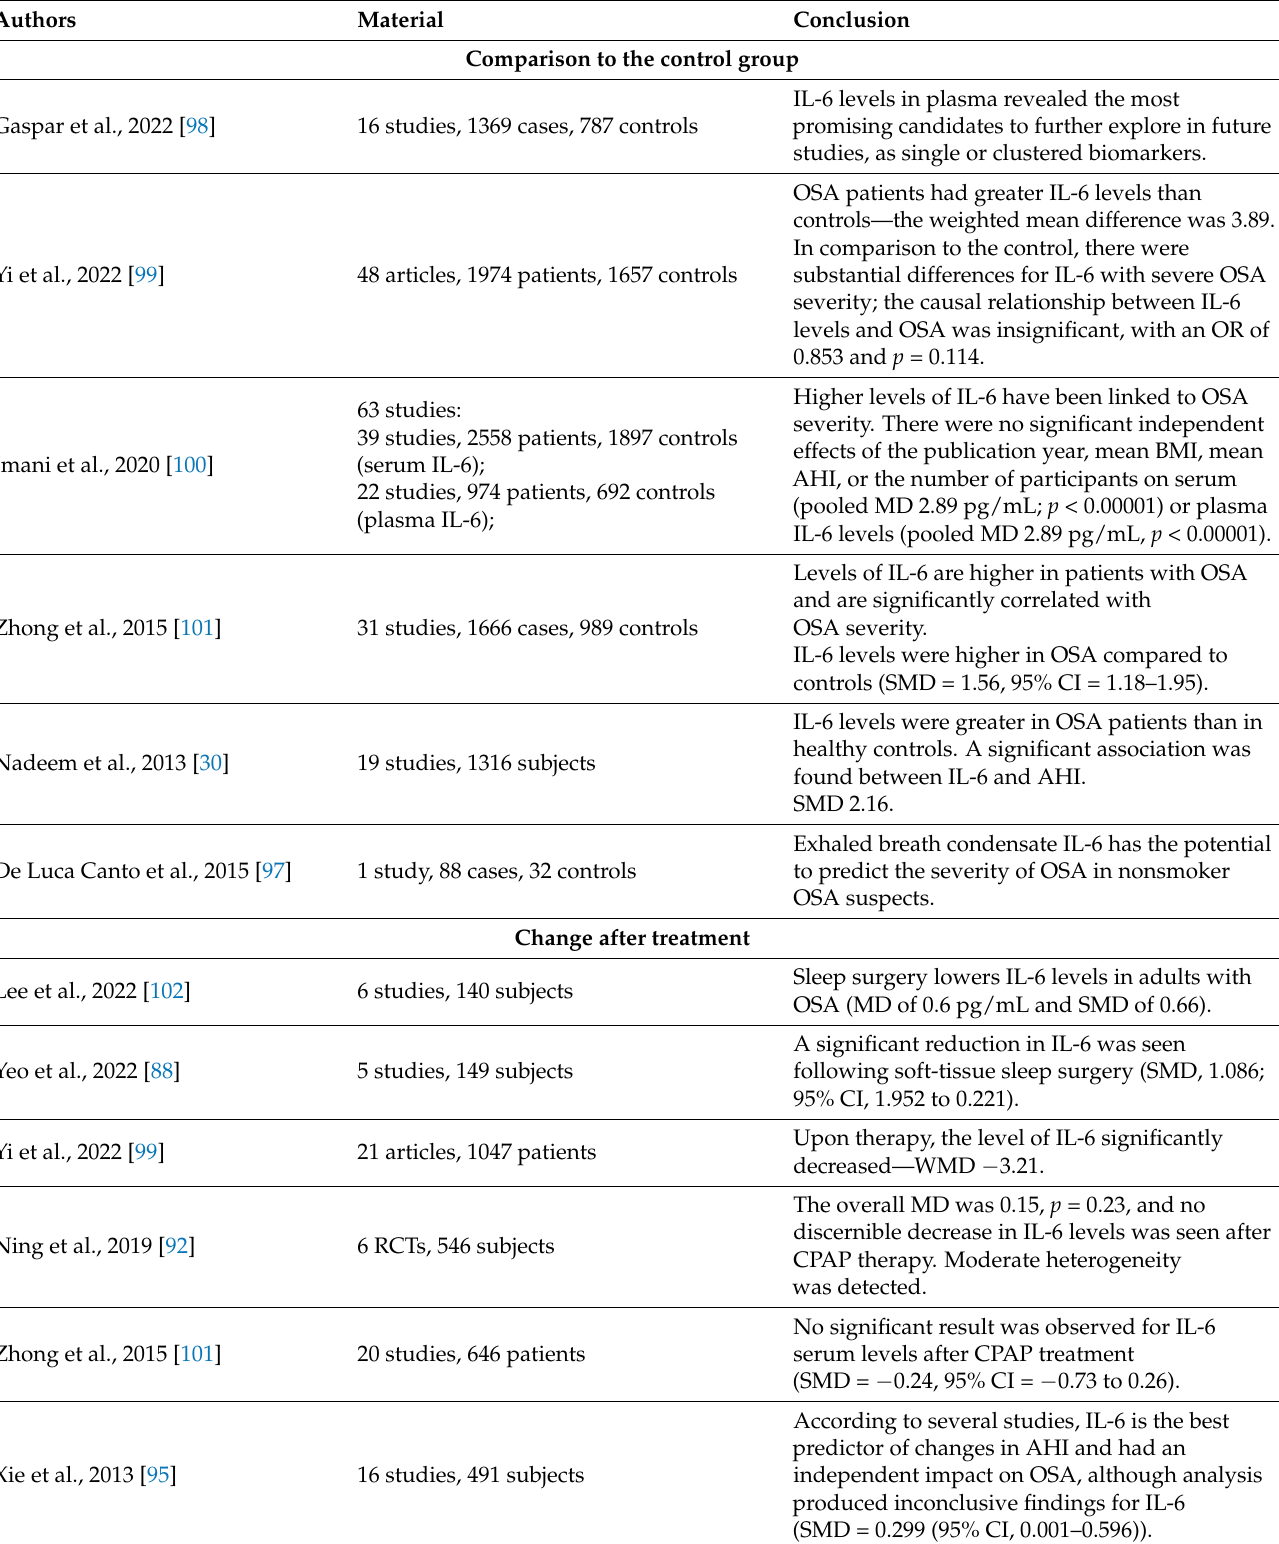
Table 4. Meta-analyses of IL-6 studies in OSA